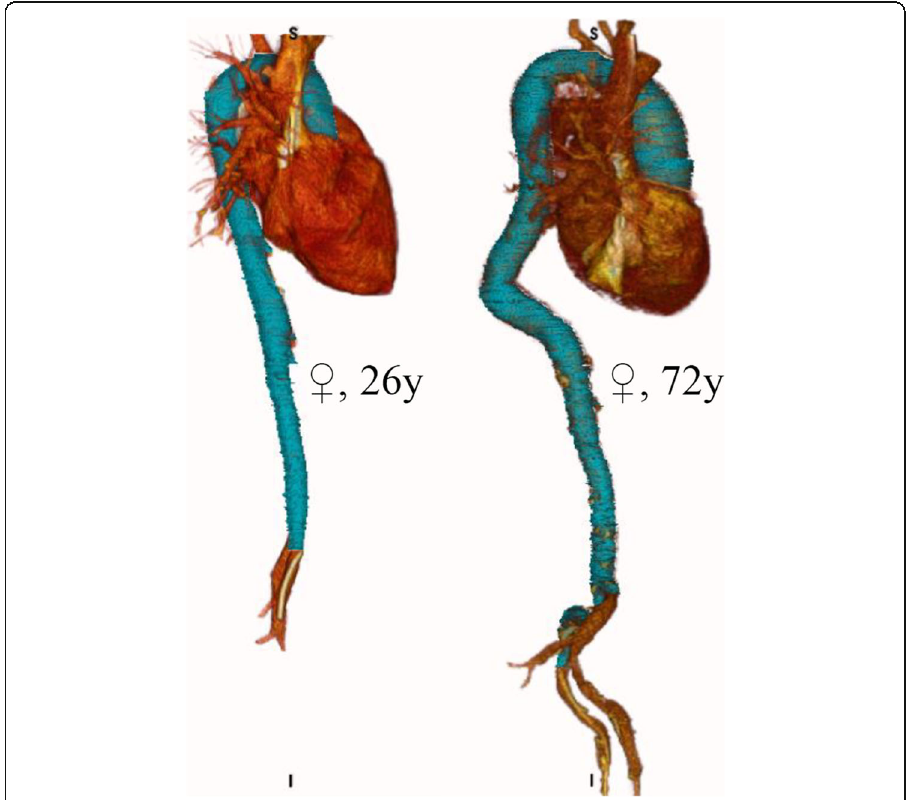
Fig. 2 Representative reconstructed three-dimensional sagittal computed tomography images of the heart and the aorta. Left side is from a 26-year-old female with meningoencephalitis and septic shock, 59 kg, 170 cm. GEDV 502 ml, GEDVI 293 ml/m 2 . Right side shows data from a 72-year-old female with aneurysmal subarachnoid hemorrhage, 165 cm, 78 kg. GEDV 1263 ml, GEDVI 787 ml/m 2 . 3D rotational images